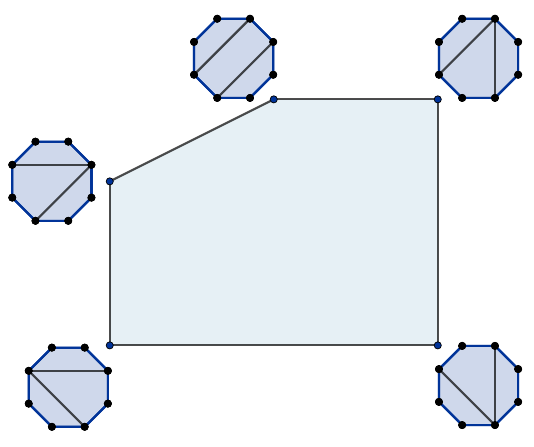
Figure 6 . Accordiohedron for dissection (14 , 47)